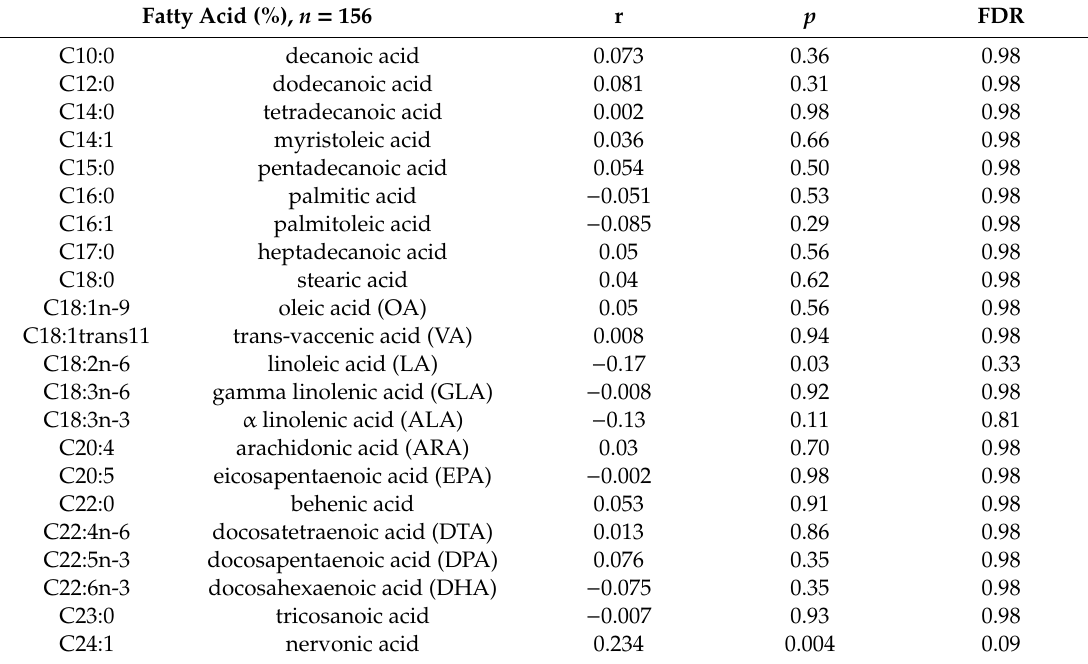
Table 4. Correlation between FA concentration and the duration of MHT (years).